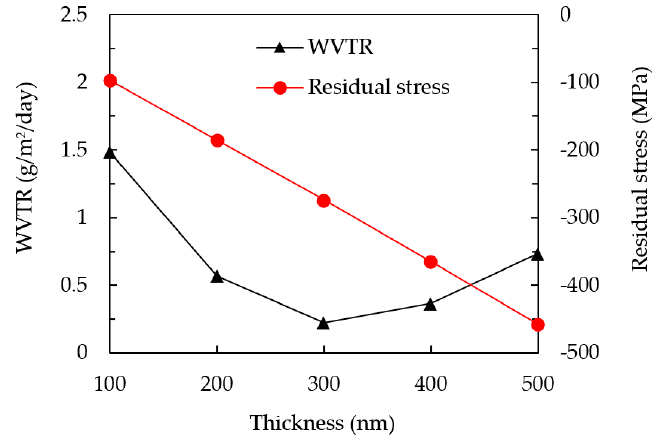
Figure 1. Water vapor transmission rate (WVTR) and residual stress of the SiO x films with different